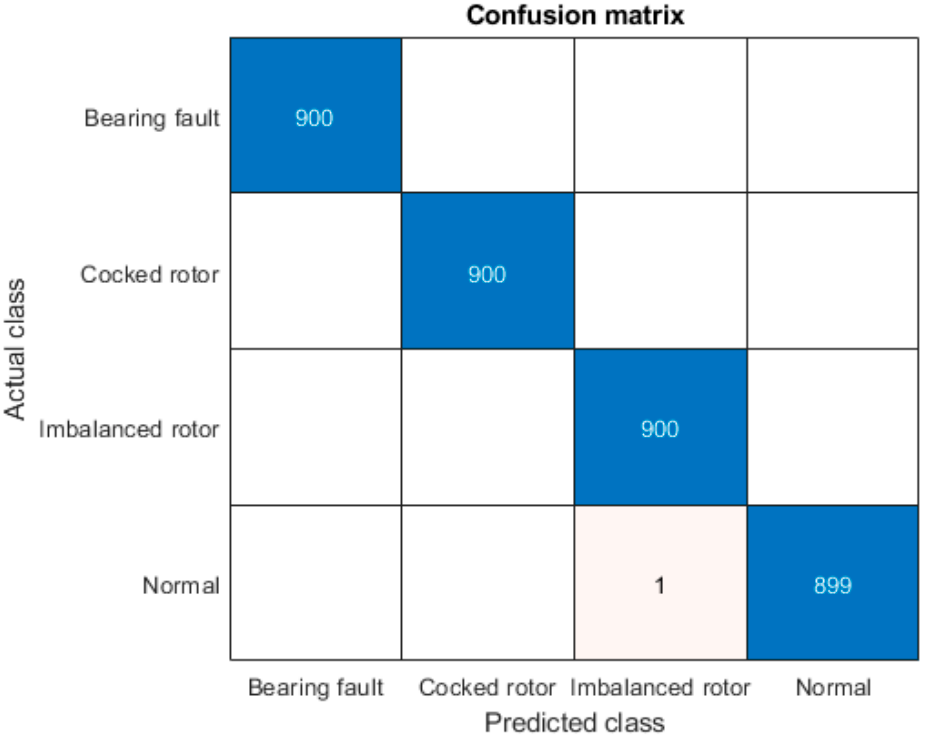
Figure 5. Confusion matrix of CNN_24–48.